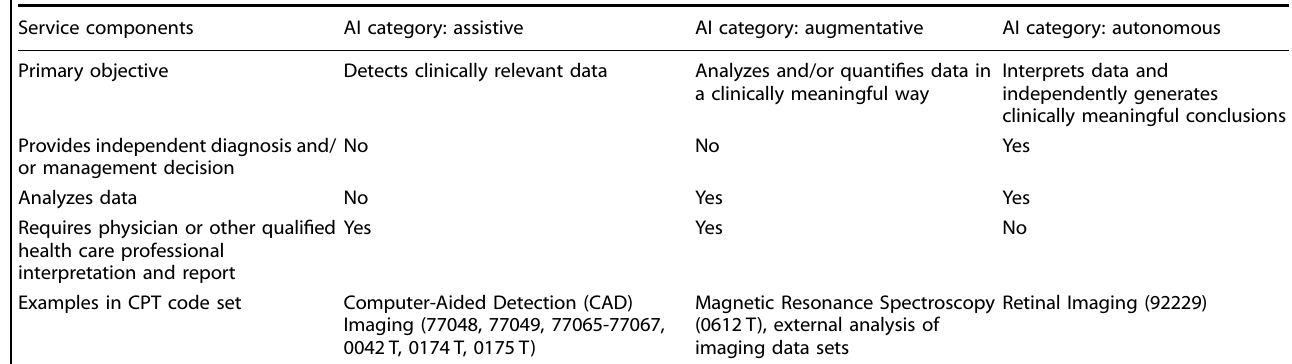
Table 2. Taxonomy for the use of augmented intelligence in